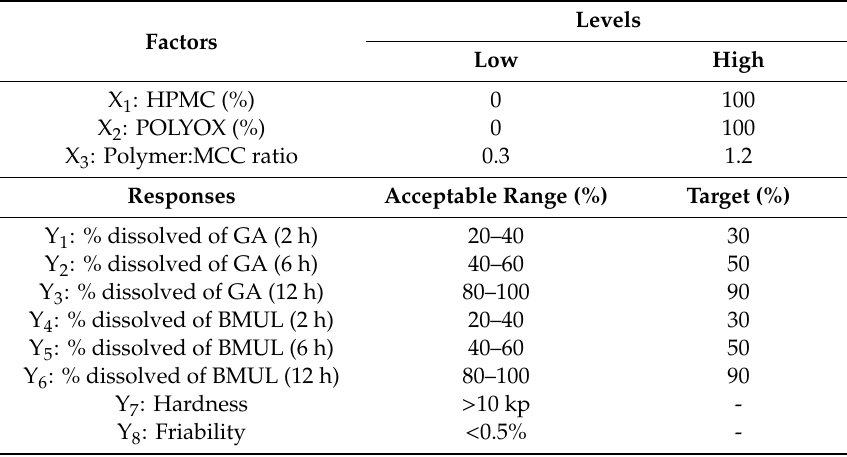
Table 2. Factors and responses used in experimental